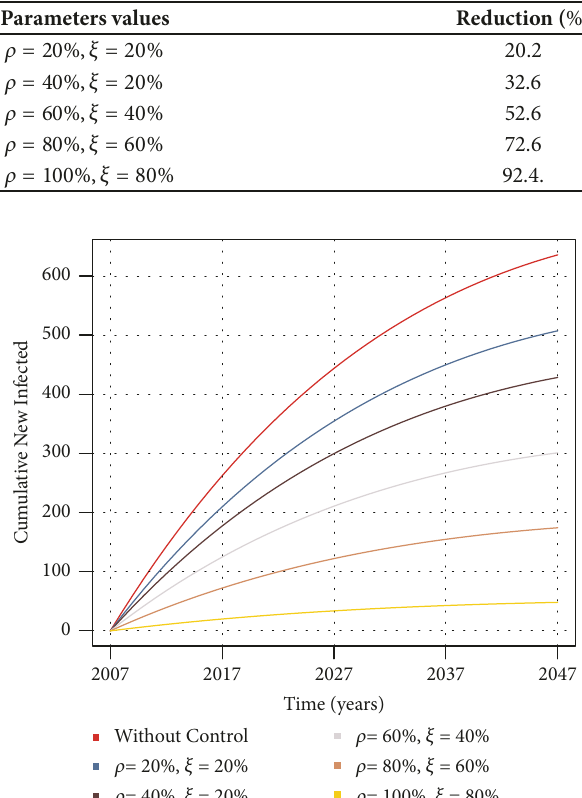
Table 4: Percentage reductions in the number of new cases due to variation in both parameters associated with control strategies – 𝜌 (percent of infected newborn treated) and 𝜉 (probability of an effective surveillance in blood transfusion).